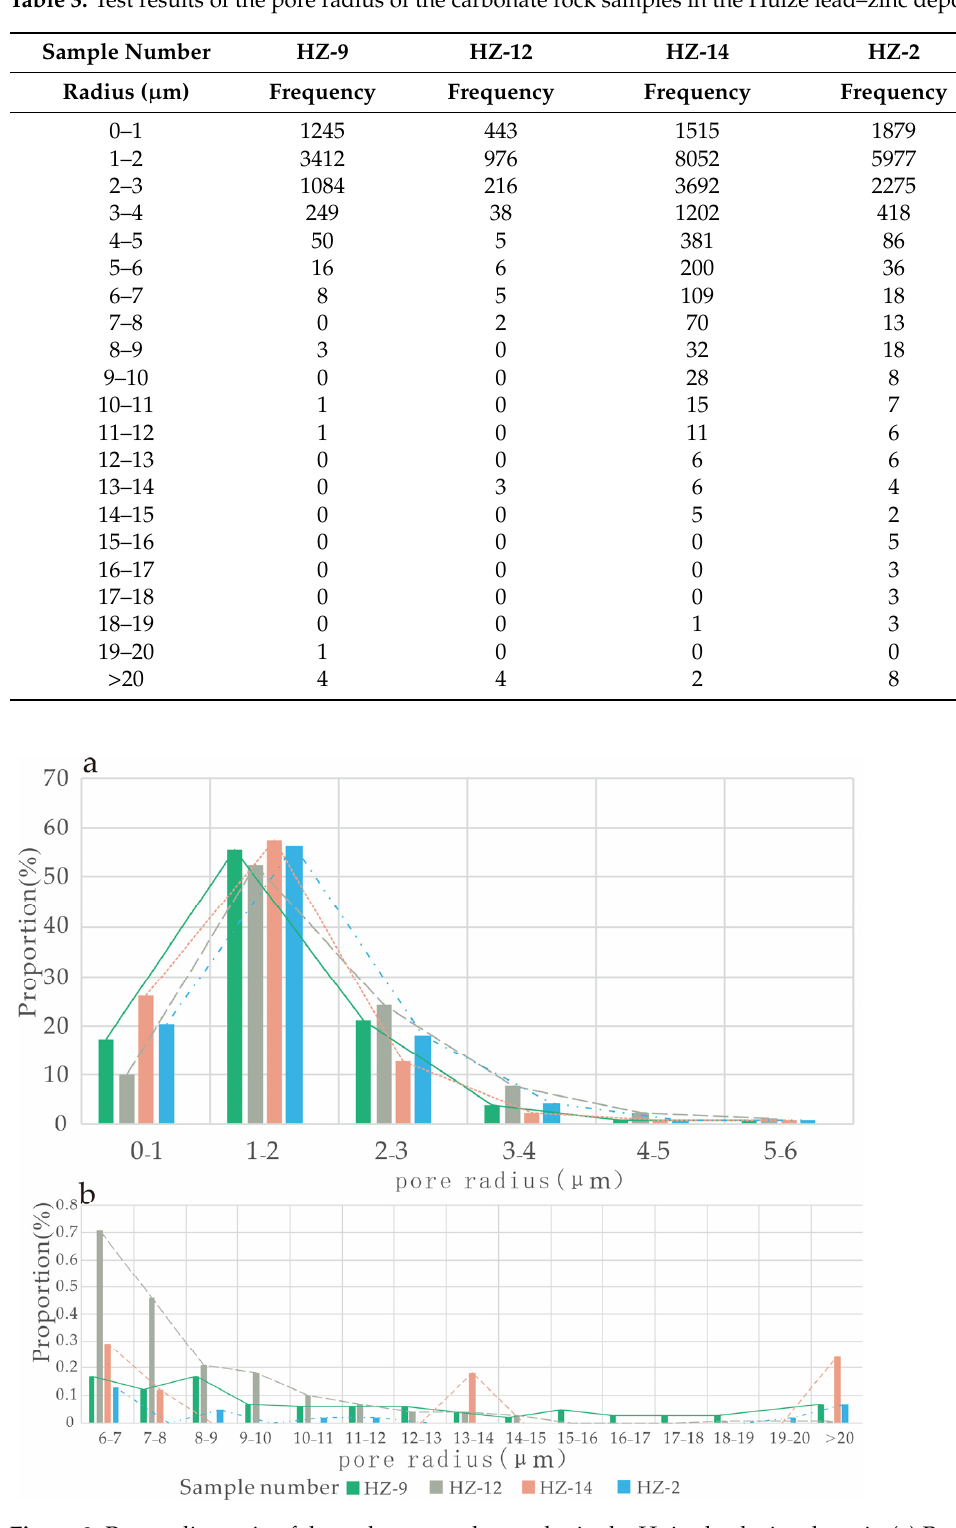
Table 3. Test results of the pore radius of the carbonate rock samples in the Huize lead–zinc de- posit.